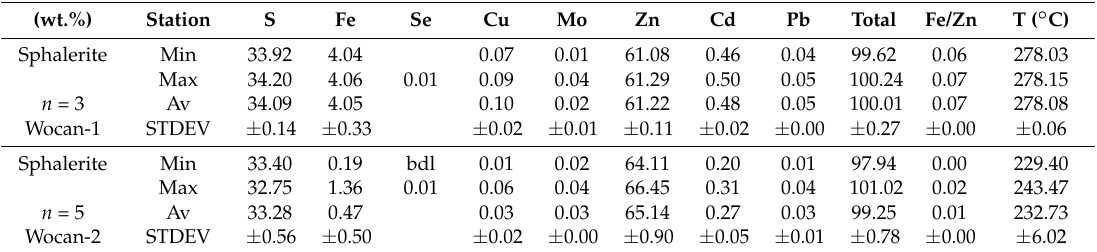
Table 5. Micro-chemical (EPMA) composition of sphalerite separates and precipitation temperature. (wt.%)